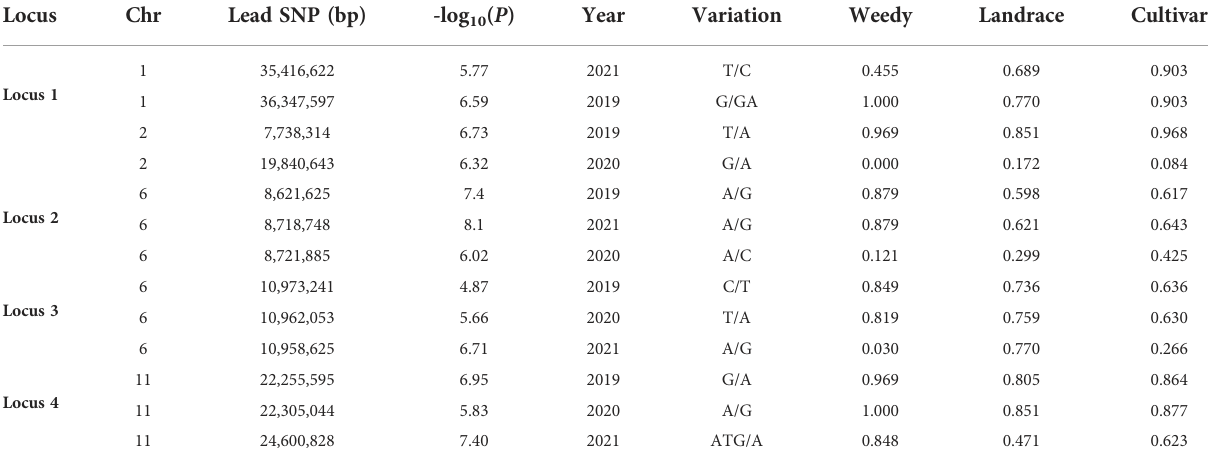
TABLE 1 Results of the genome-wide association analysis.